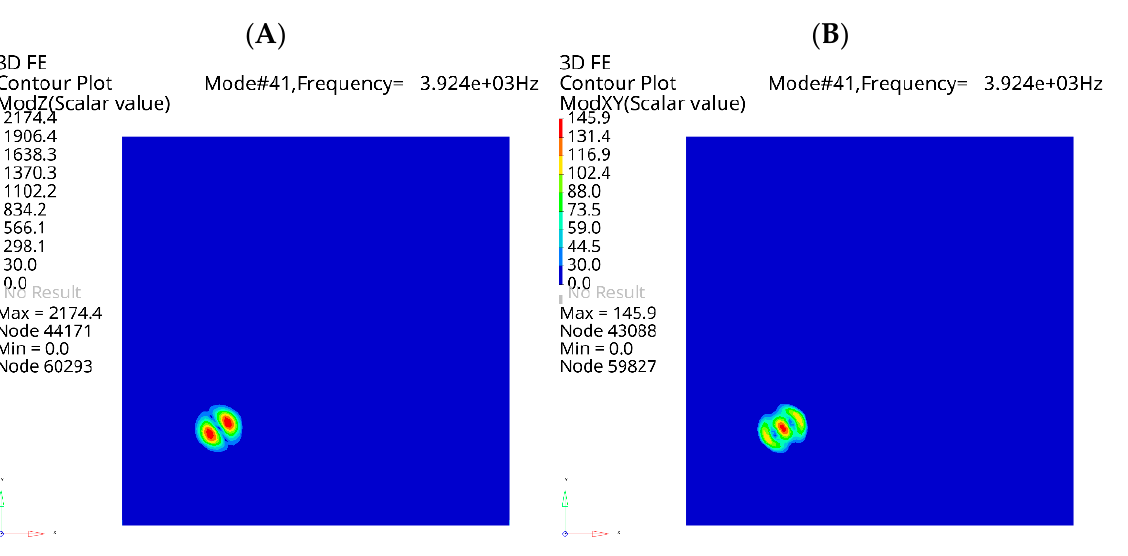
Figure 13. One of the mode shapes of FBH Ø40 mm LDR: out-of-plane component ( A ) and in-plane component ( B ).